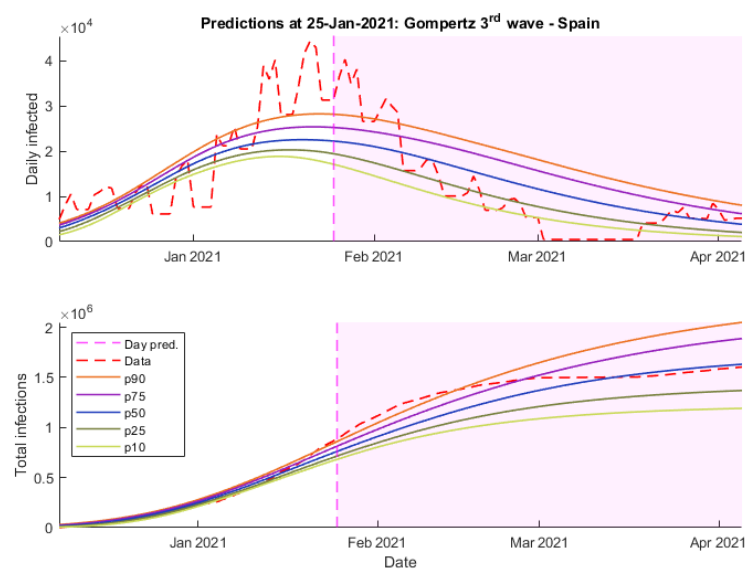
Figure 13. Predictions 25 January 2021 wave 3 SIR — Spain.